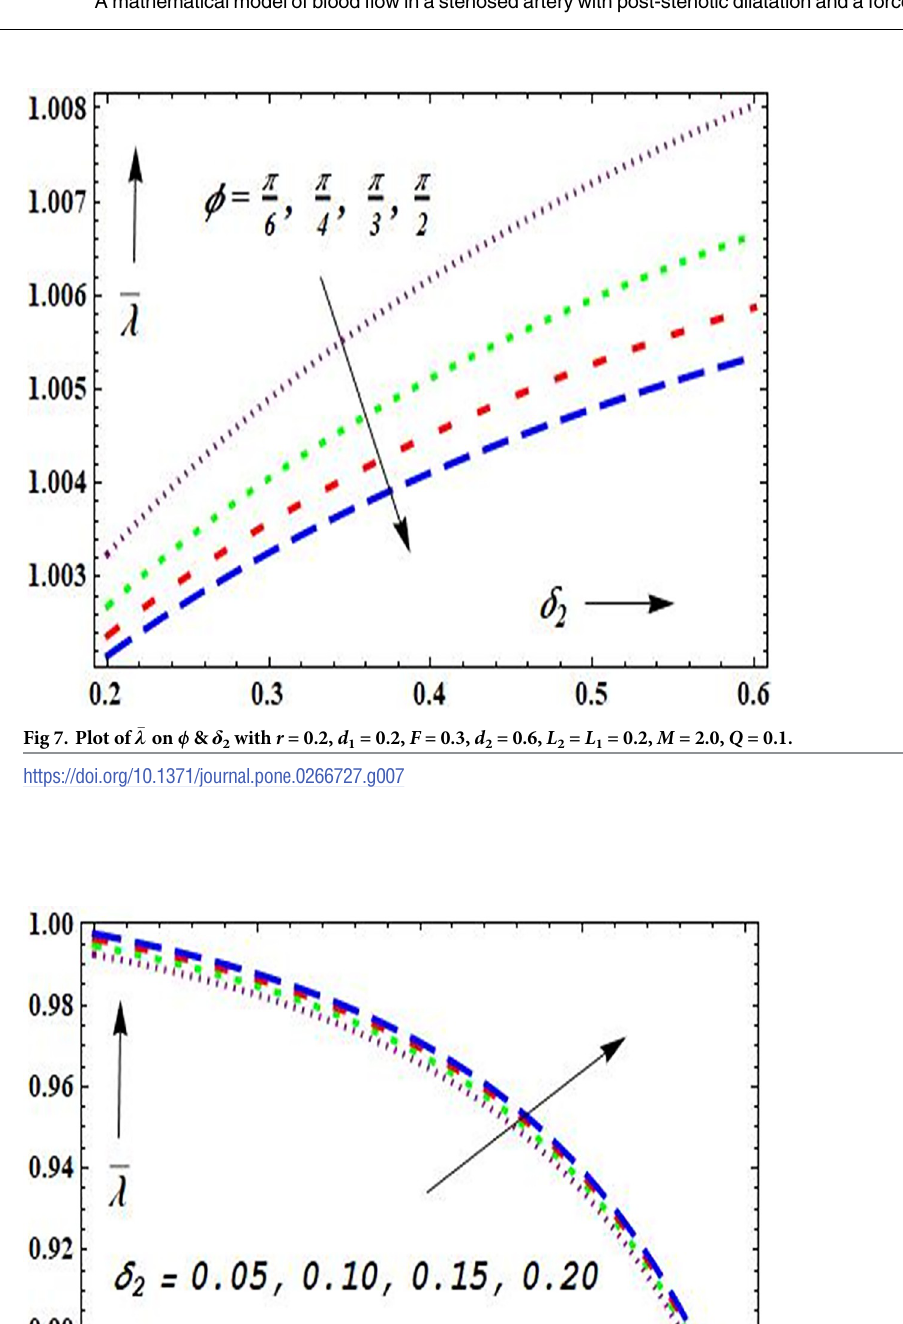
; r ¼ 0 : 2 ; d ¼ 0 : 2 ; F ¼ 0 : 3 ; d 1 6